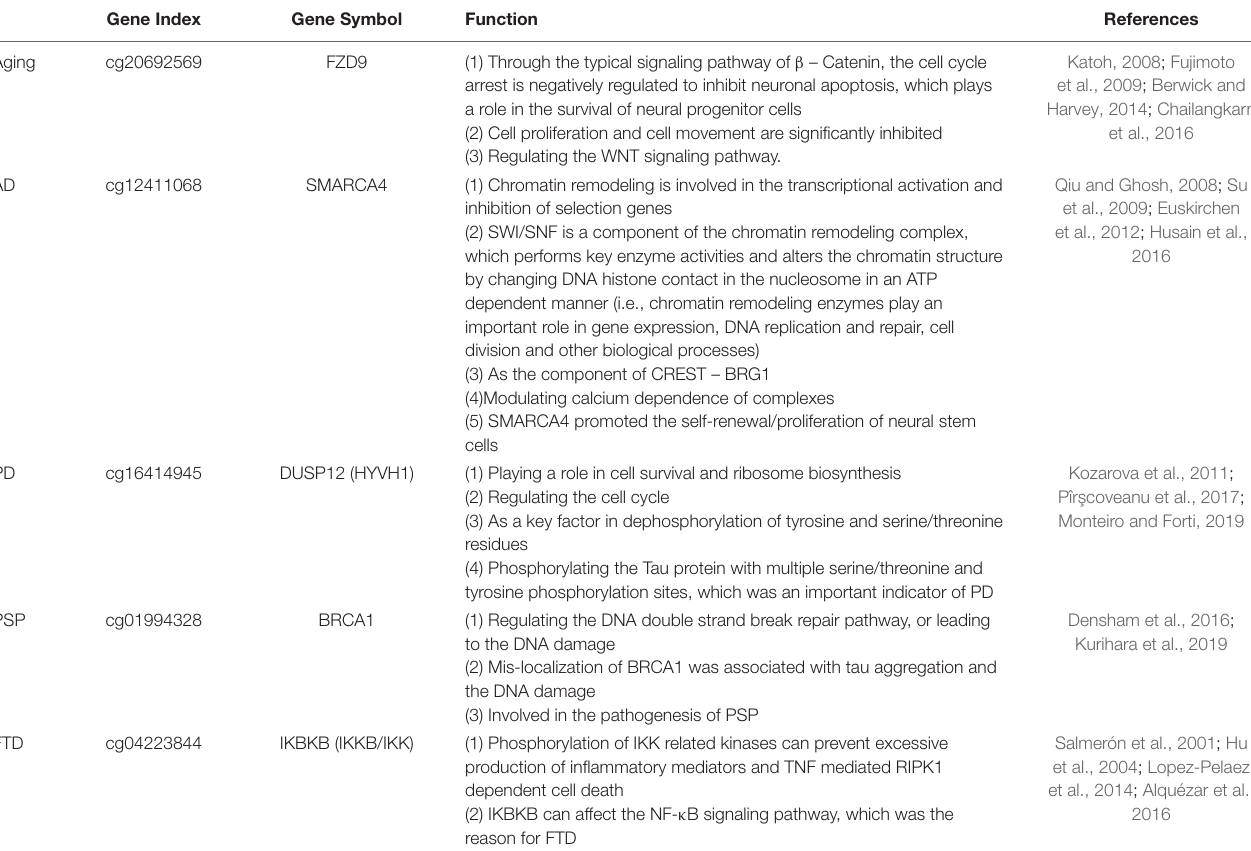
TABLE 2 | The top risk markers of aging and ND. Gene Index Gene Symbol